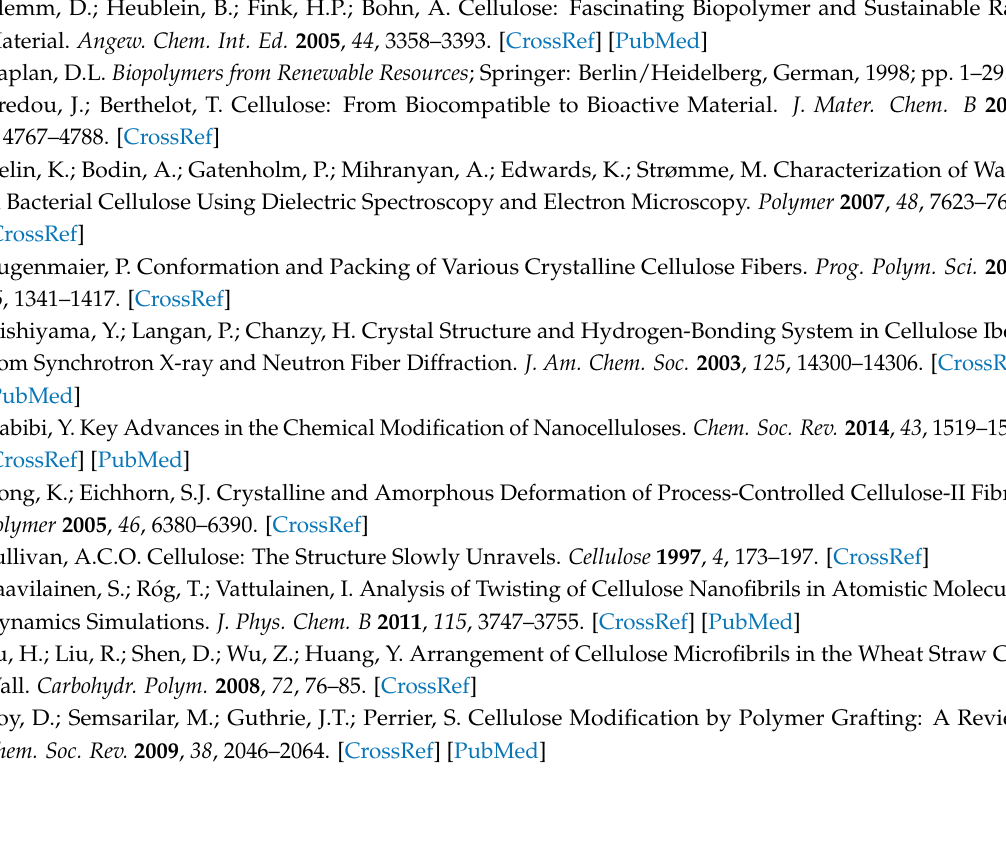
Figure S1: SEM of physically treated cellulose particles in NaOH solution, Figure S2: Shear stress and shear viscosity curves of the ER fluid containing physically treated cellulose in NaOH